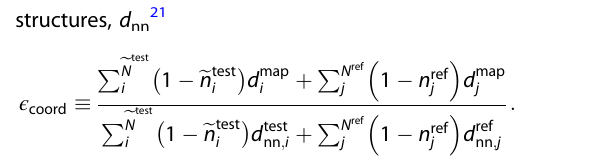
Fig. 3 Available super-type comparison modes. a Material-type: maps same element types, revealing duplicate compounds. b Structure- type: maps structures regardless of the element types, identifying crystallographic prototypes. c Decoration-type: creates and compares all atom decorations for a given structure, determining unique and equivalent decorations (in this case, atom decorations AB and BA match). d Magnetic-type: maps compounds by element types and magnetic moments, discerning distinct spin con fi